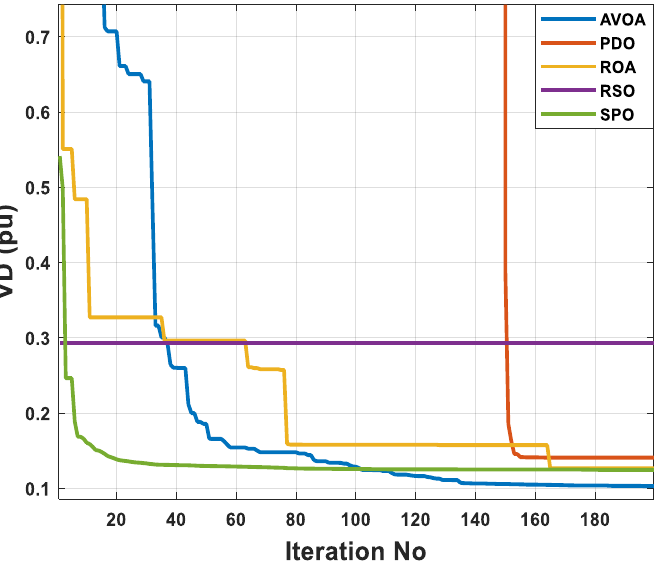
Figure 3. The AVOA voltage profile with the other compared methods for case 1.